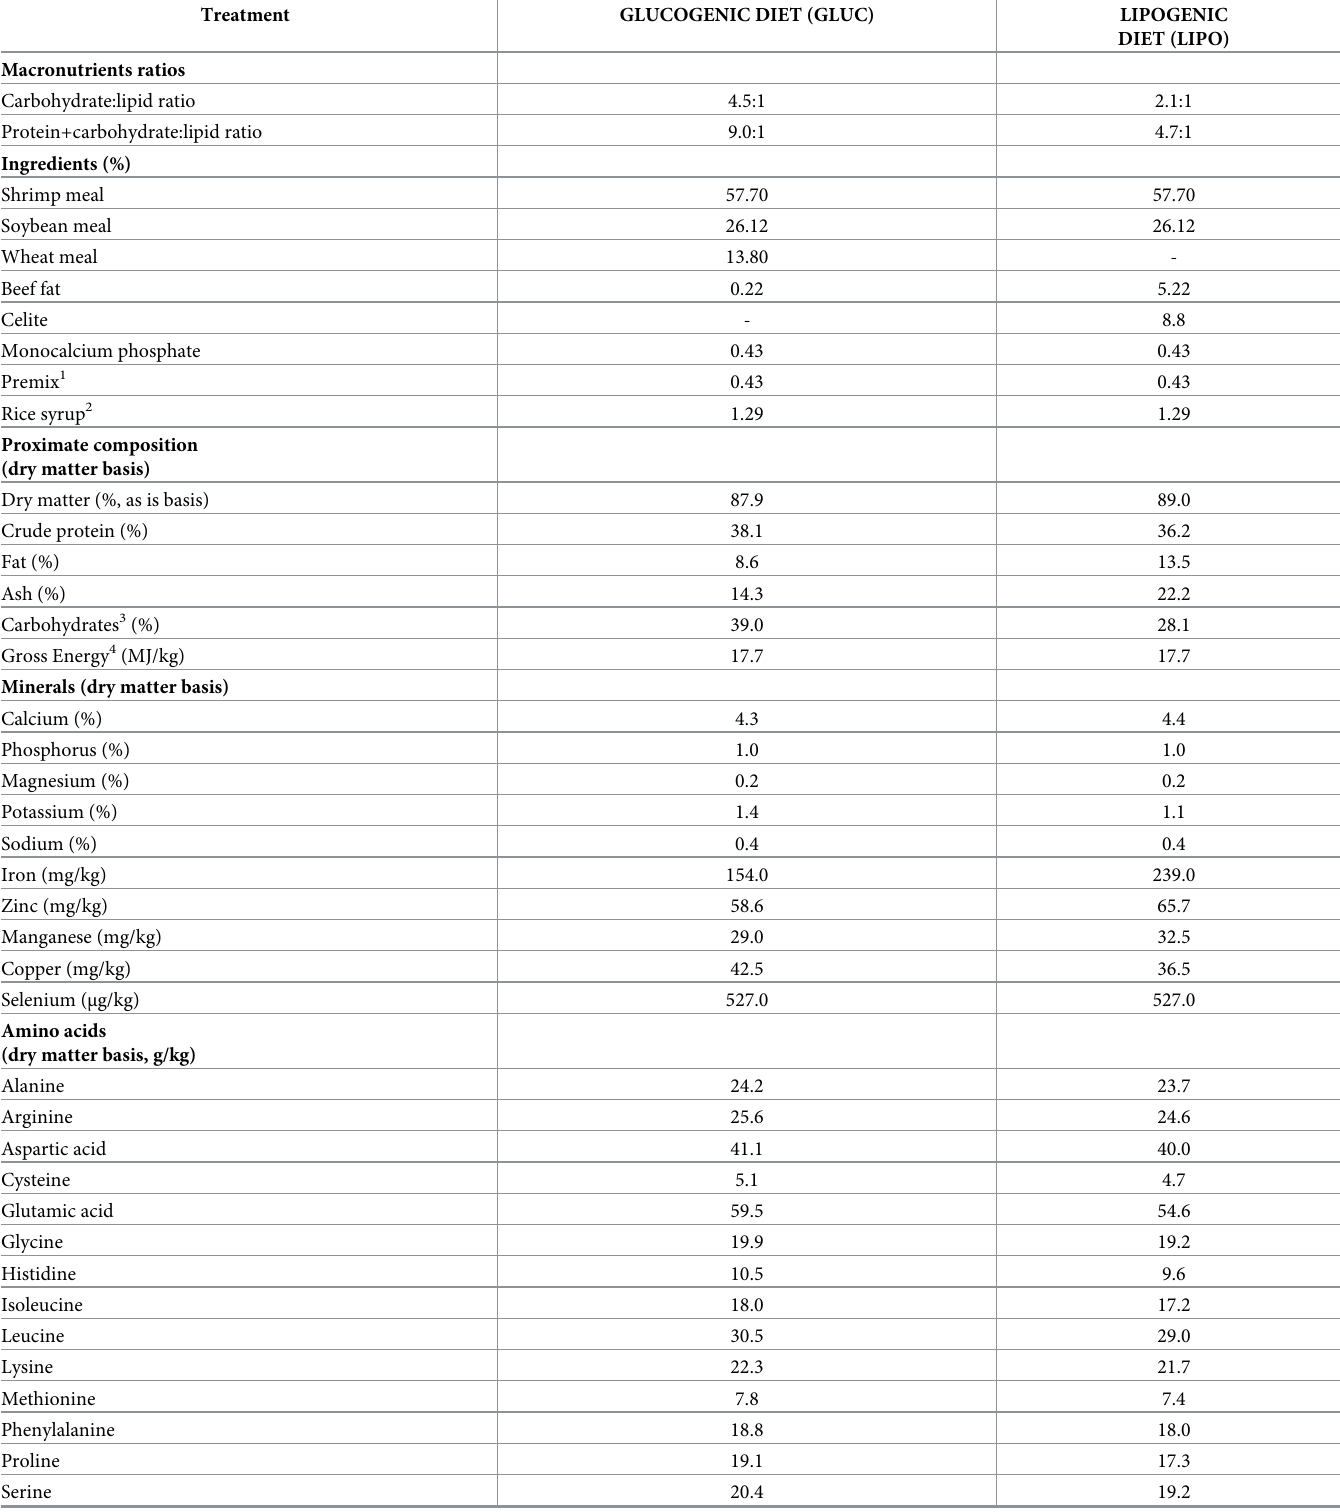
Table 1. Formulas and nutritional composition of diets offered to X . laevis